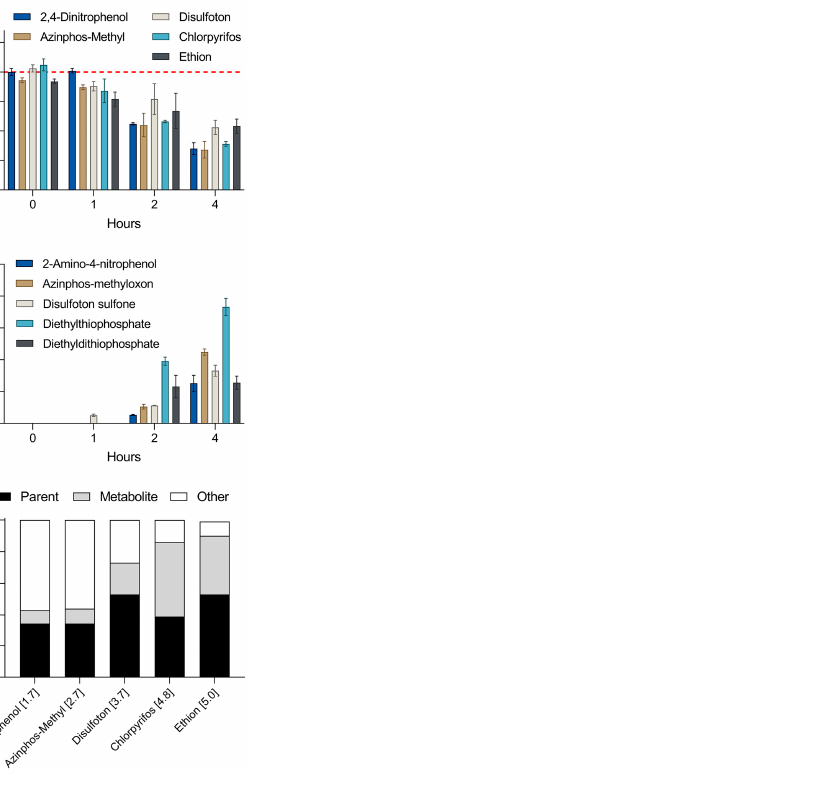
Figure 5. Comparison of in vitro metabolism of 1 µ M equimolar mixture in suspension assay and metabolite formation through nontargeted analysis: ( A ) Plotted are % remaining values (mean ± SD) for chemicals that showed clearance in suspension assay. Values were derived by dividing the abundance of each chemical by the abundance of the corresponding compound in control experiment (boiled hepatocytes). ( B ) Graphed are abundances (mean ± SD) of metabolites detected through nontargeted analyses. Metabolites correspond to the parent compound by matching color. Two- way ANOVA with Tukey’s multiple comparisons tests revealed statistical differences between % remaining for parent compounds and feature abundances of metabolites. Summary of statistical information including p values can be found in Table S5. ( C ) Stacked bar graphs showing the mass balance distribution of abundances for each chemical between parent compound, metabolite, and other. The number in brackets next to each compound represents the log- p